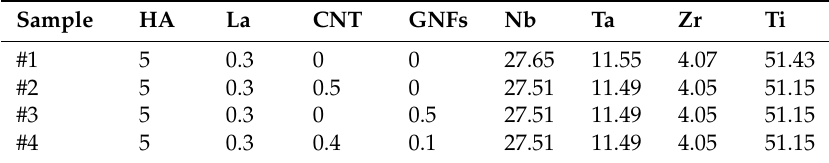
Table 1. The ingredients list of the experiment (wt %).